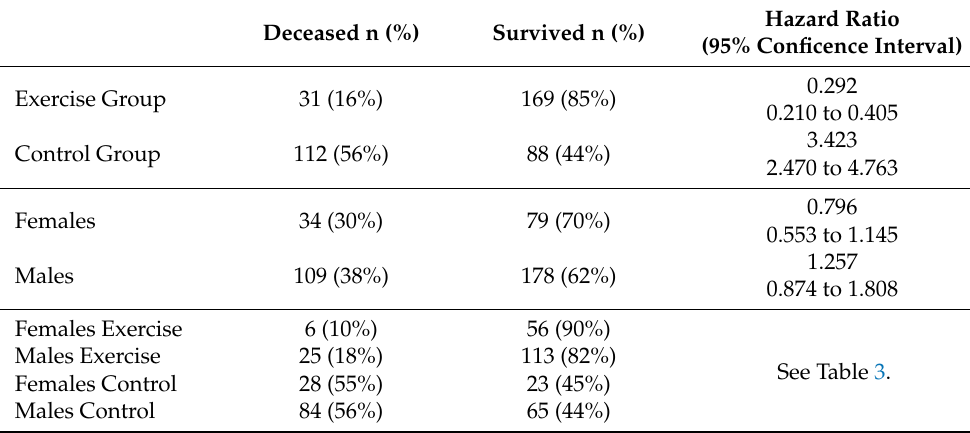
Table 2. Number of deaths for each group and subgroup and hazard ratios for risk of mortality comparison between the exercise vs. control group and females vs. males.